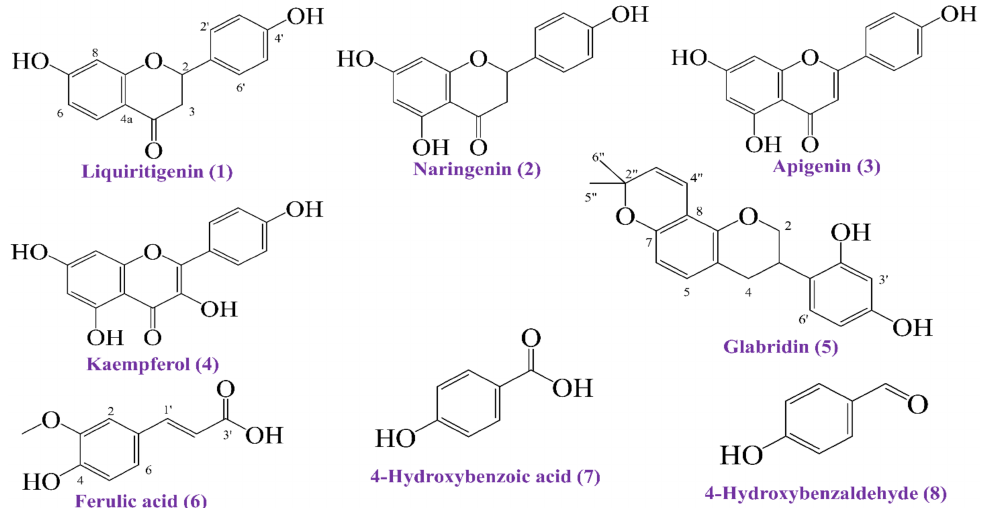
Figure 1. Structures of the isolated eight compounds ( 1 – 8 ) from the stem extract of W. tinctoria